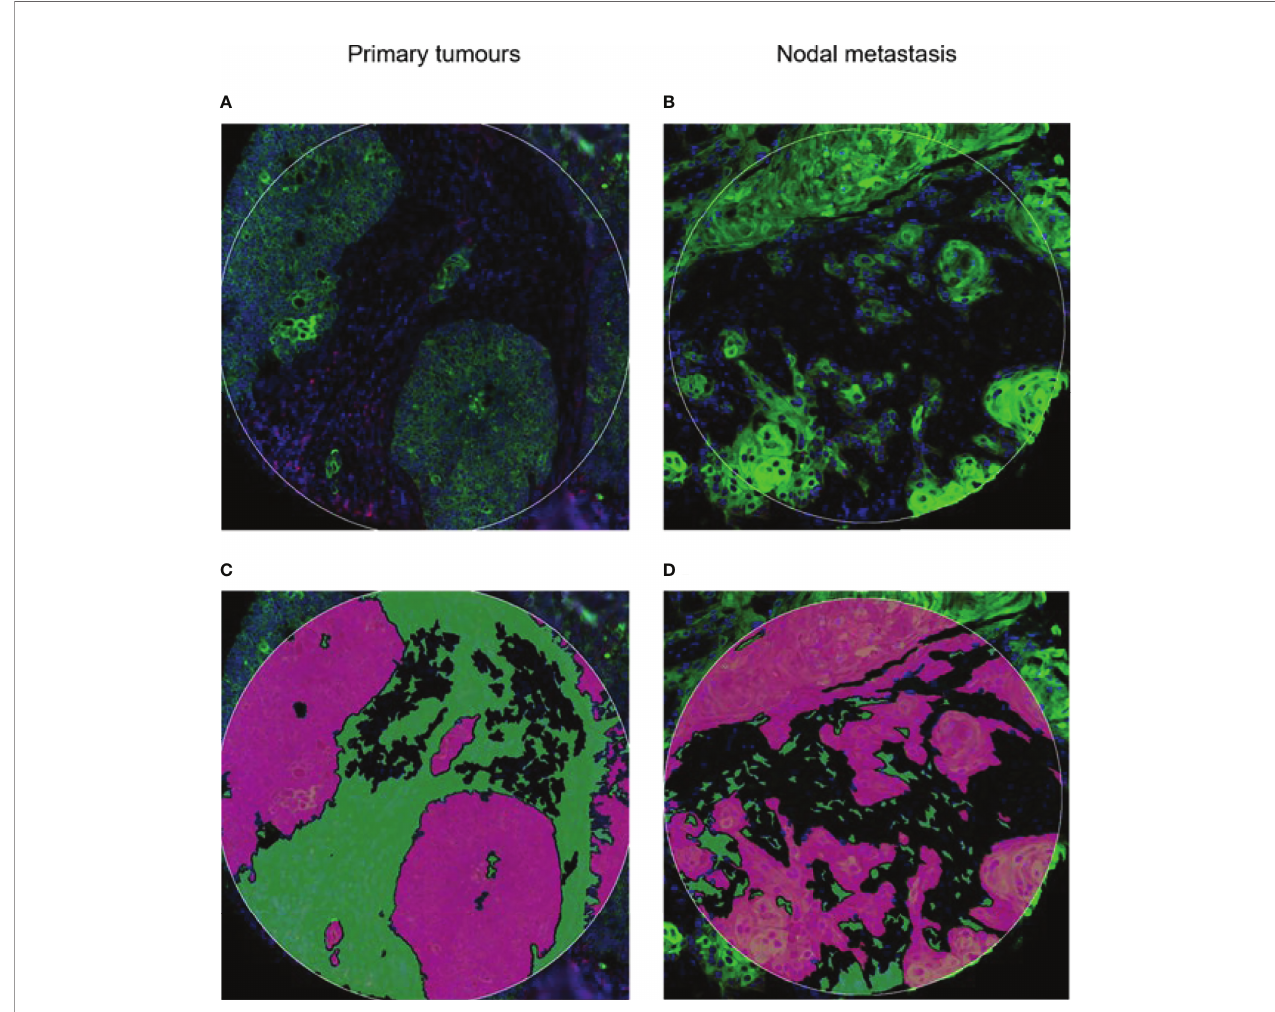
FIGURE 1 | Spatial pro fi ling was performed on tumor microarray cores from (A) primary and (B) nodal metastasis. Tissues were stained for PanCK + (Tumor) and PanCK − (Stroma) areas. Green, PanCK; Red, CD45. Tissue segmentation strategy to capture (C) Tumor mask in purple and (D) stromal regions in green. Masks were generated per PanCK + / − feature to liberate barcodes for digital counting by